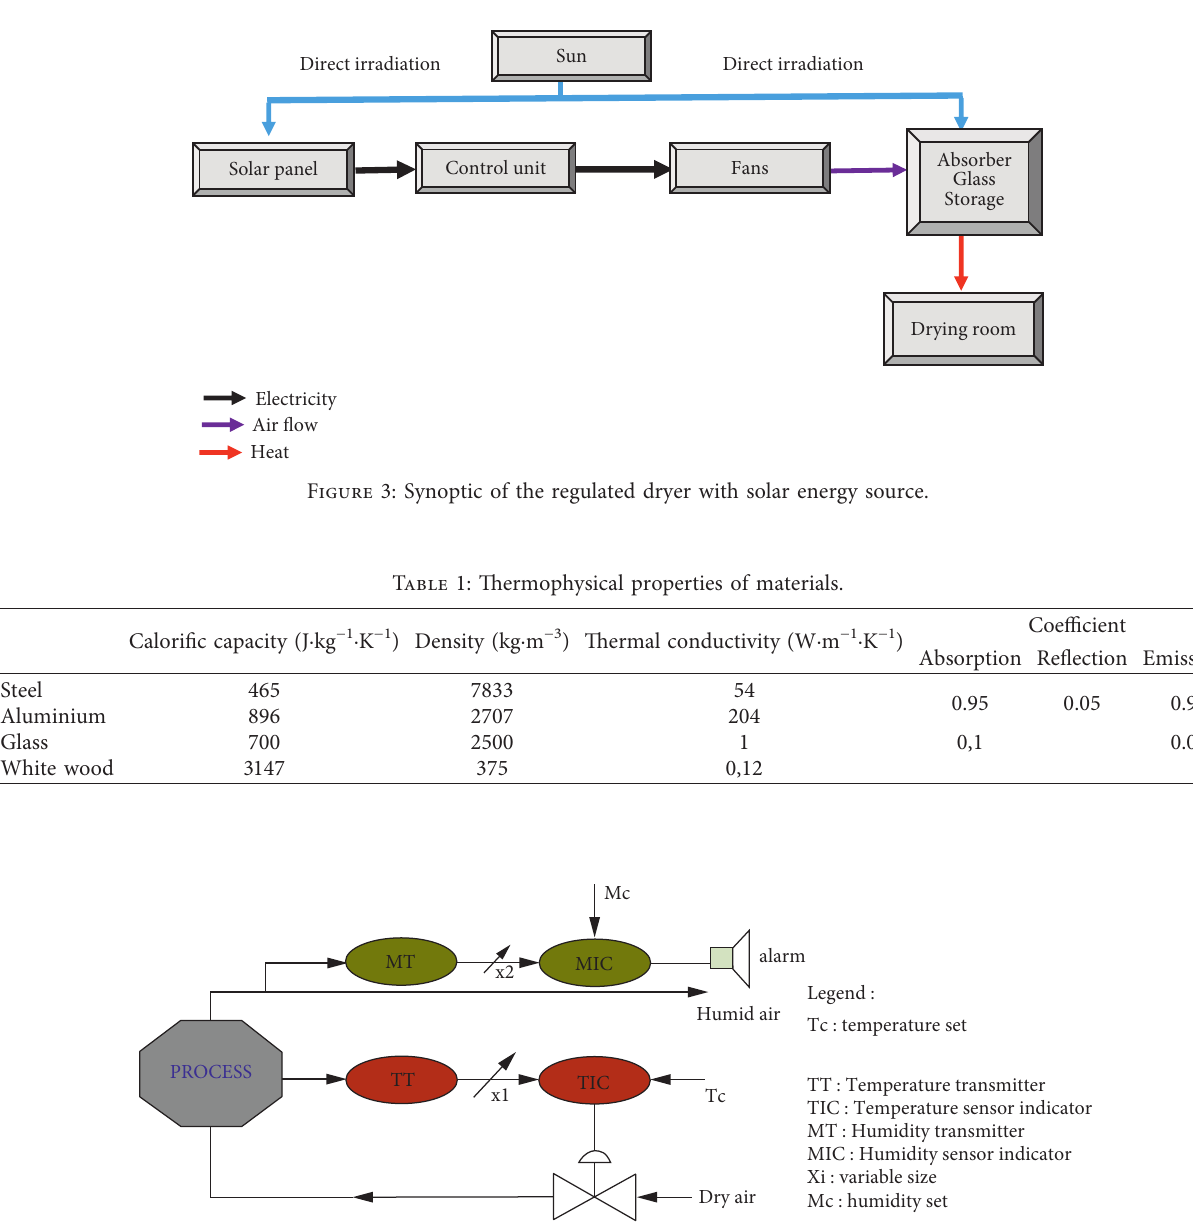
Figure 4: Instrumentation